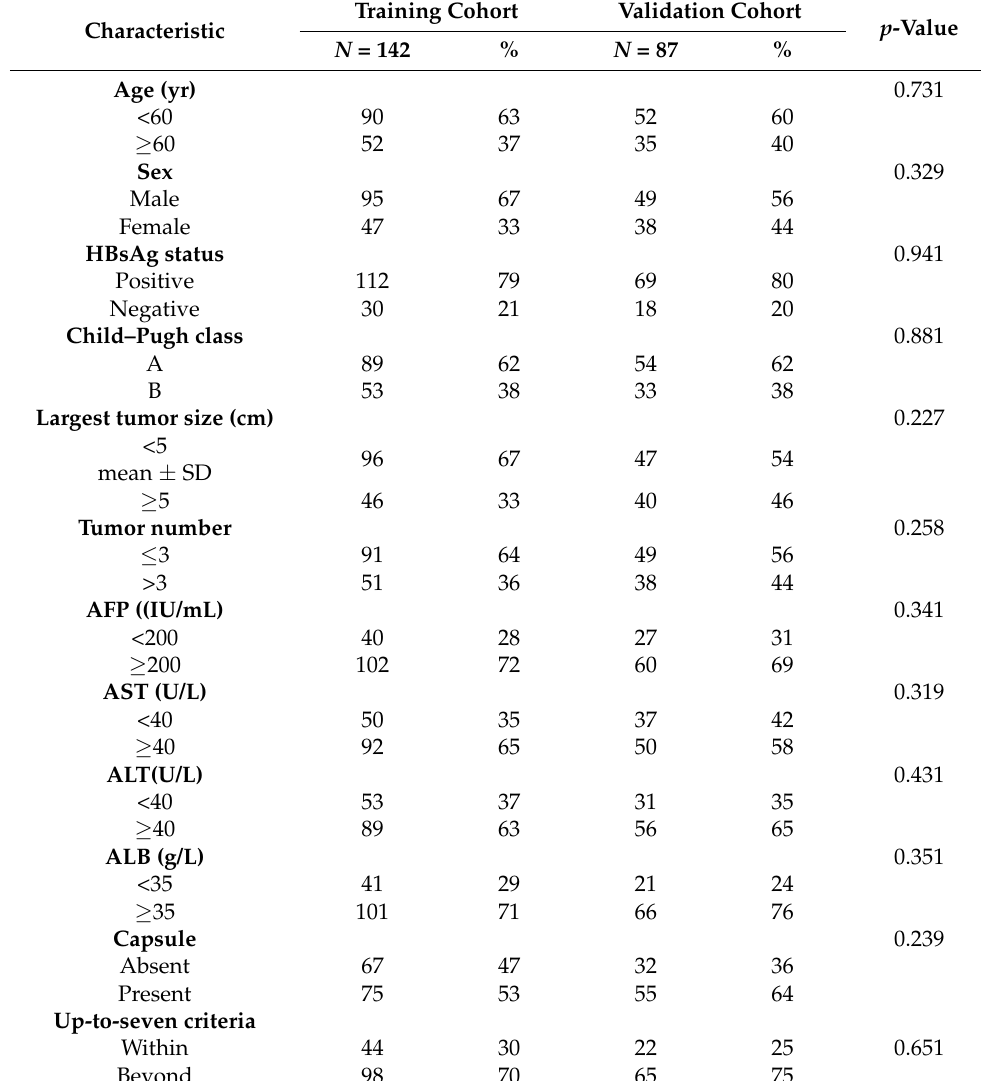
Table 1. Patient